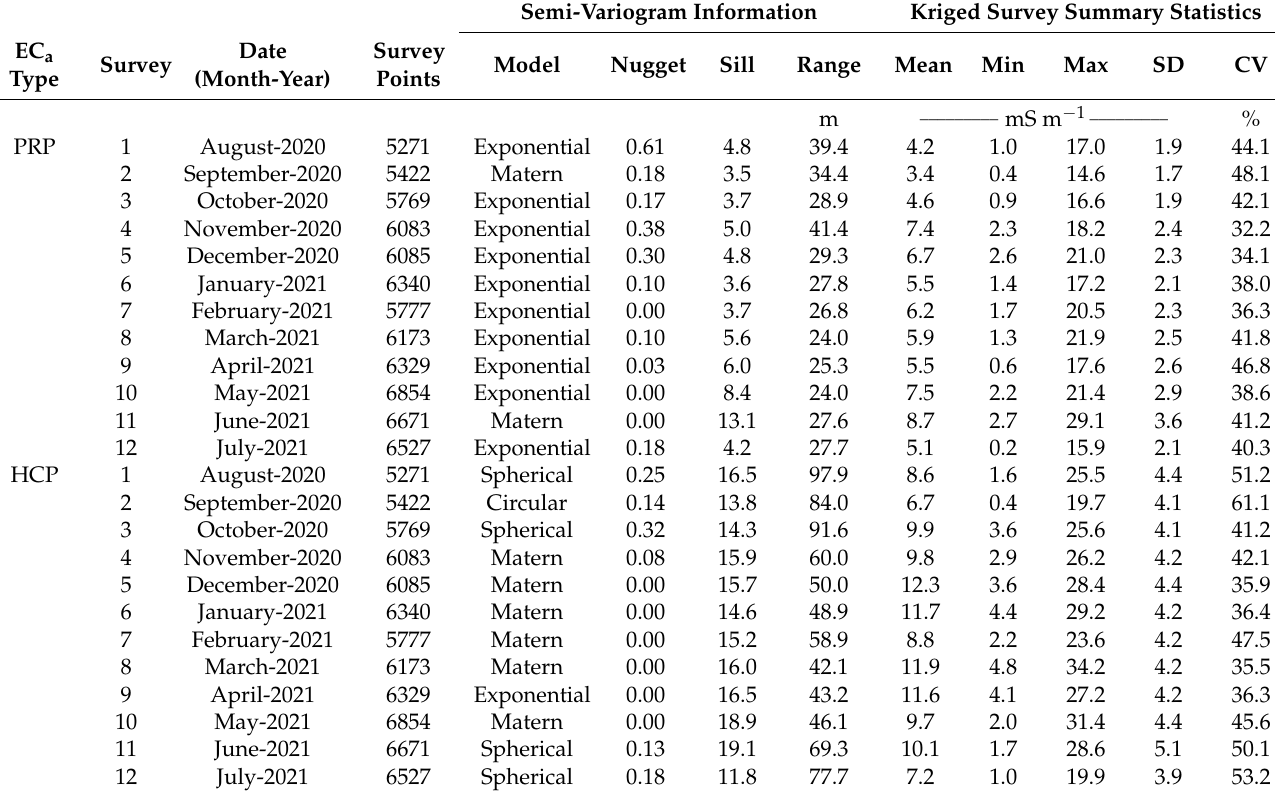
Table 3. Summary of the perpendicular geometry (PRP) and horizontal coplanar geometry (HCP) apparent electrical conductivity (EC a ) survey dates, number of measurements per survey, semi- variogram information (i.e., experimental model, nugget, sill, and range), and resulting summary statistics (i.e., mean, minimum (min), maximum (max), standard deviation (SD), and coefficient of variation (CV)) of each PRP and HCP EC a survey after universal kriging at an agroforestry site